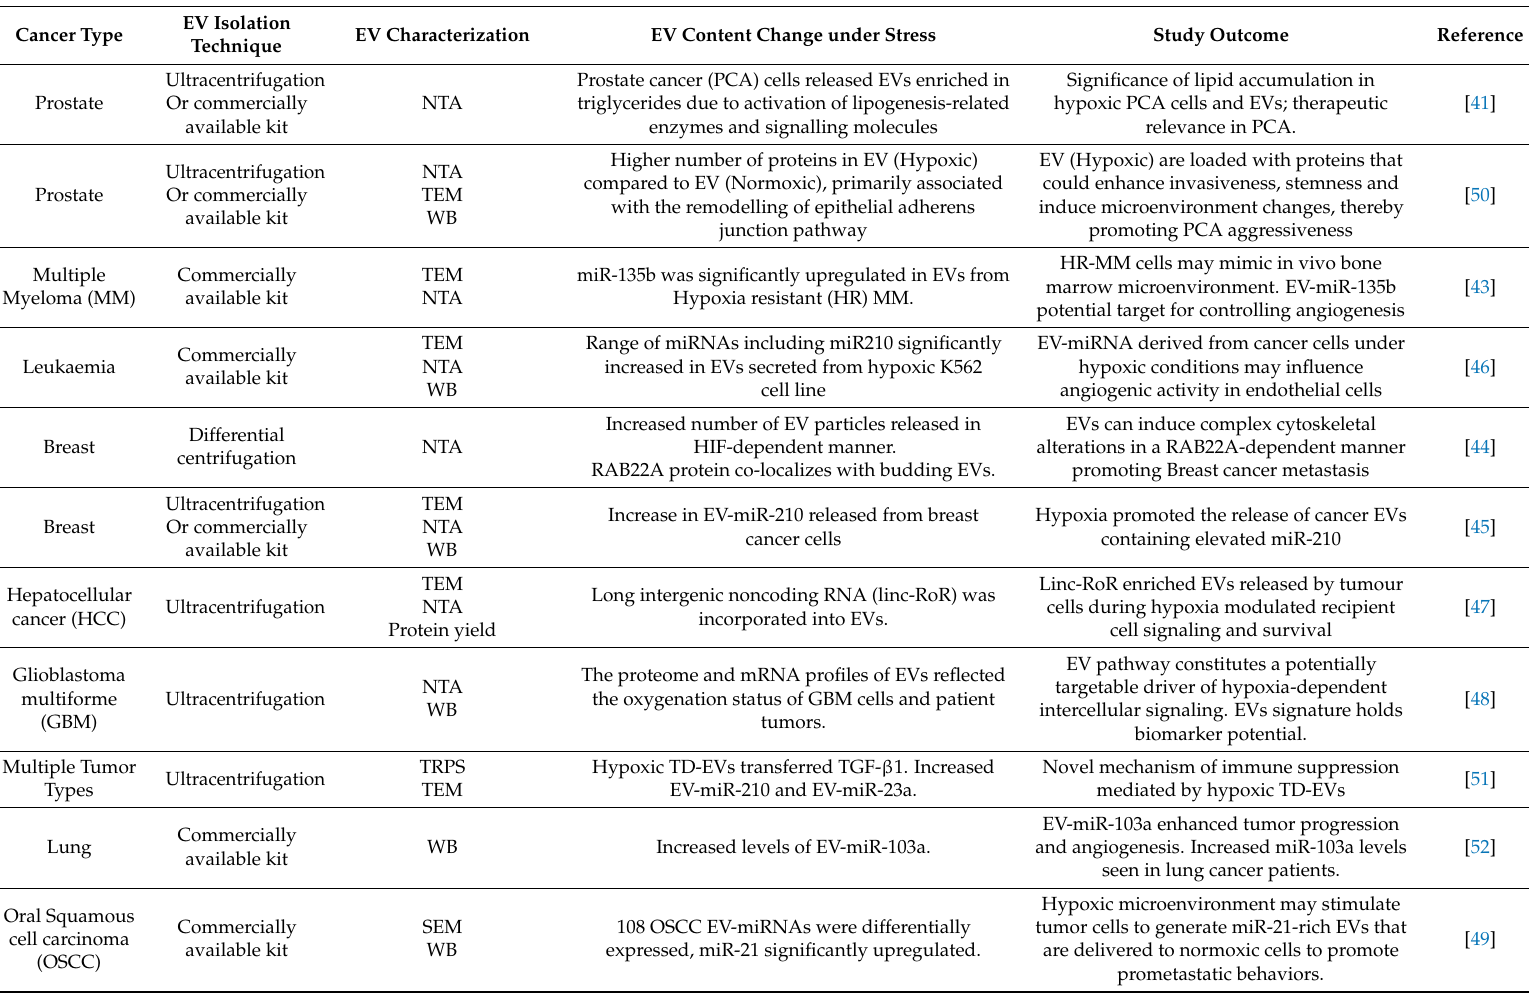
Table 1. Impact of hypoxia on EV release and content. NTA: Nano Particle Tracking Analysis; TEM: Transmission Electron Microscopy; WB: Western Blot; HIF: Hypoxia Inducible Factor; TRPS: Tunable Resistive Pulse Sensing; TD-EV: Tumor Derived Extracellular Vesicles; TGF: Transforming Growth